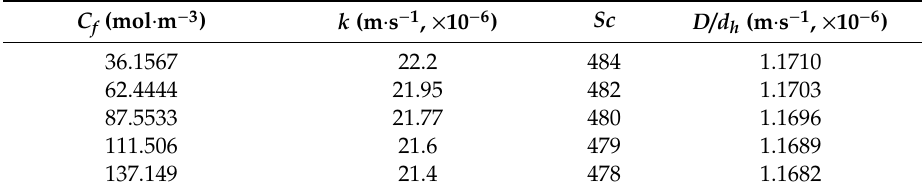
Table 4. Value of k and Schmidt number (Sc) under different C f ( Q f = 155.56×10 − 6 m 3 ·s − 1 , pH = 6, T = 306 K, R = 8.314 J·mol − 1 ·K − 1 ).